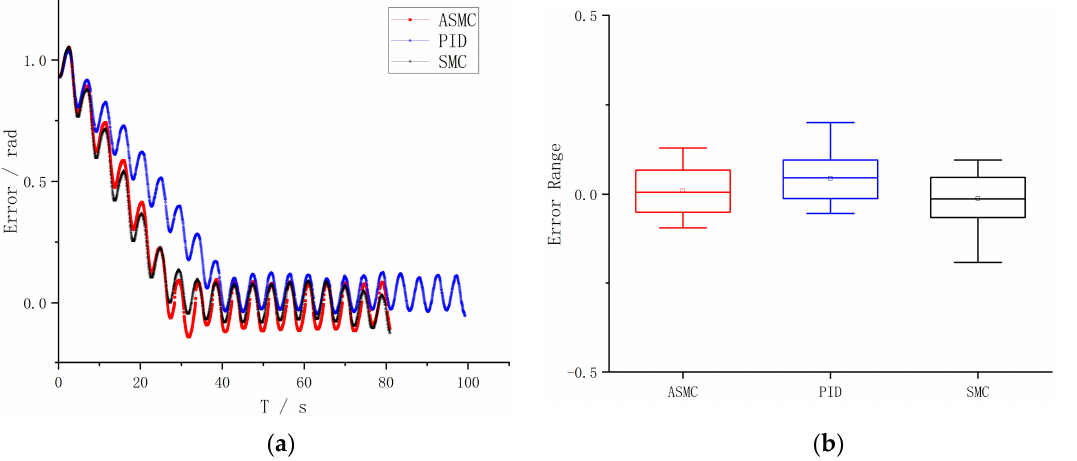
Figure 13. Comparison of control error results of each controller: ( a ) The error curve of the direction angle; ( b ) Box plot of state error.